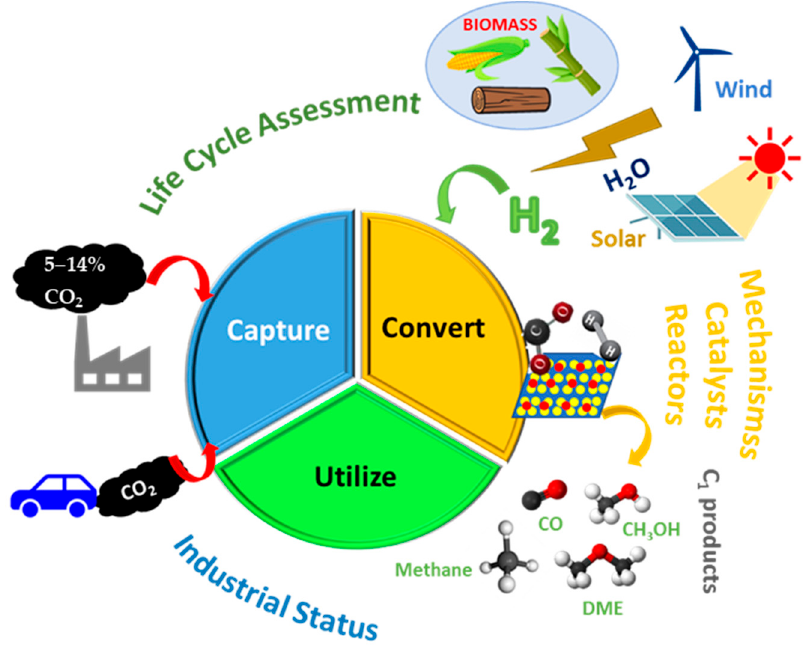
Figure 2. Selective circular process demonstrating the “two birds, one stone” advantage of chemical transformation of captured CO 2 into fuels or chemical commodities over other technologies for simple capture and